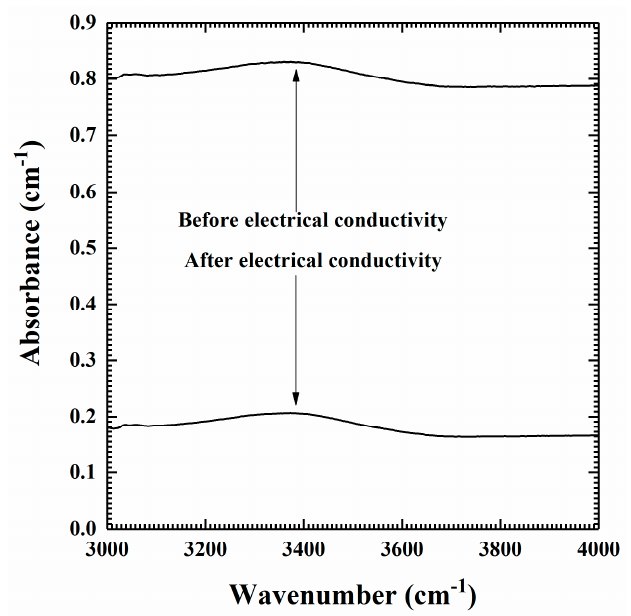
Figure 2. Fourier transform infrared (FTIR) spectra of olivine aggregates in the wavenumbers range of 3000–4000 cm –1 before and after electrical conductivity measurements.